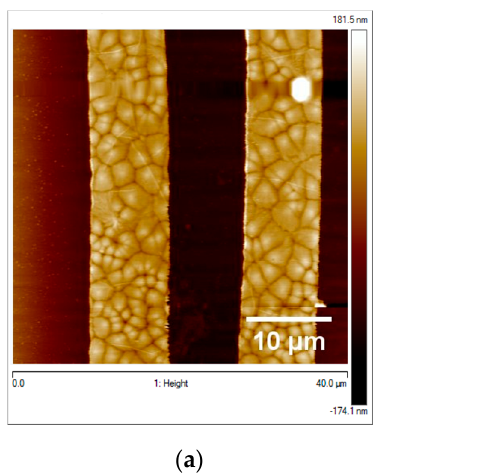
of the 2 µ m dimeter